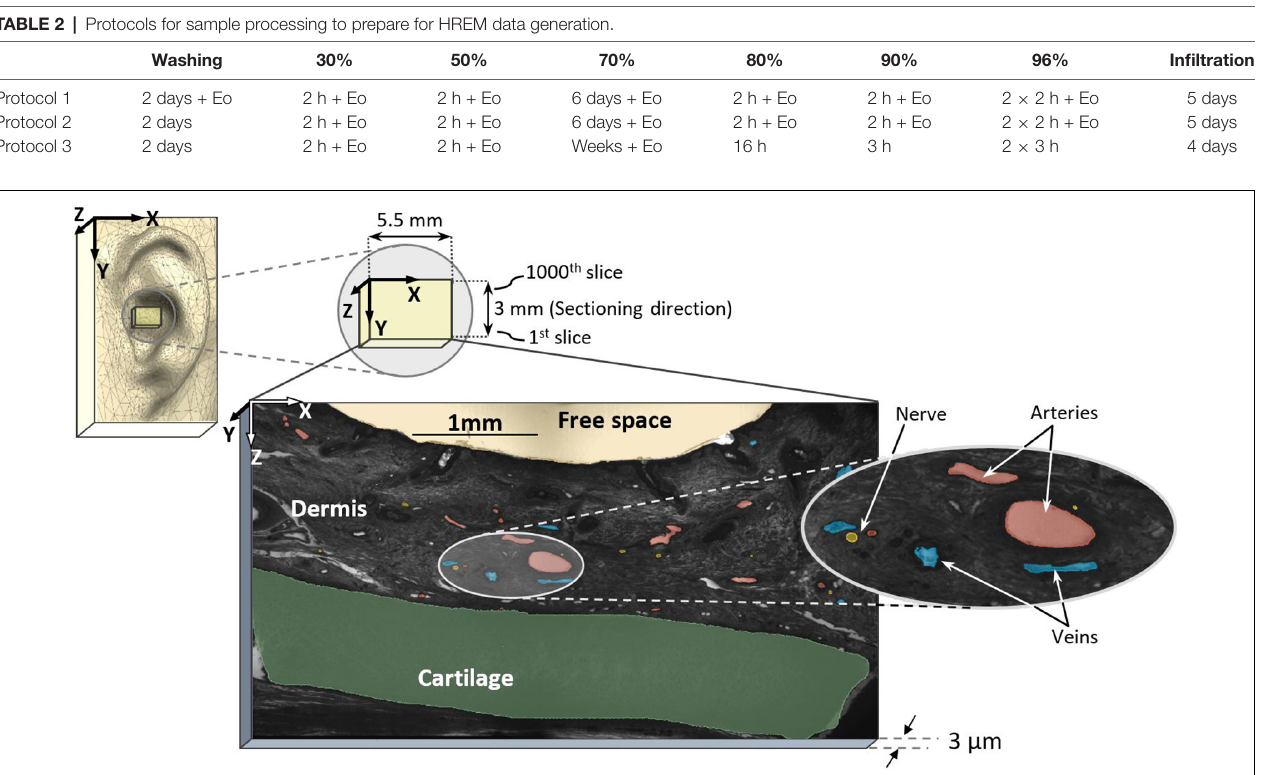
FIGURE 1 | Sampling region in external pinna of the ear and high-resolution episcopic imaging (HREM) image with marked arteries (red), nerves (yellow), and veins